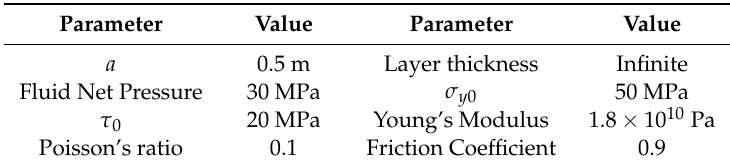
Figure 6. The stress and the displacement discontinuities along the natural fracture when the natural fracture has zero tensile strength. ( a ) The normal and shear stresses; ( b ) the normal and shear fracture displacement discontinuities. Table 1. Input parameters for simulating the shearing of a single fracture. Here, a refers to the half- length of the fracture section that is filled by pressurized fluid.